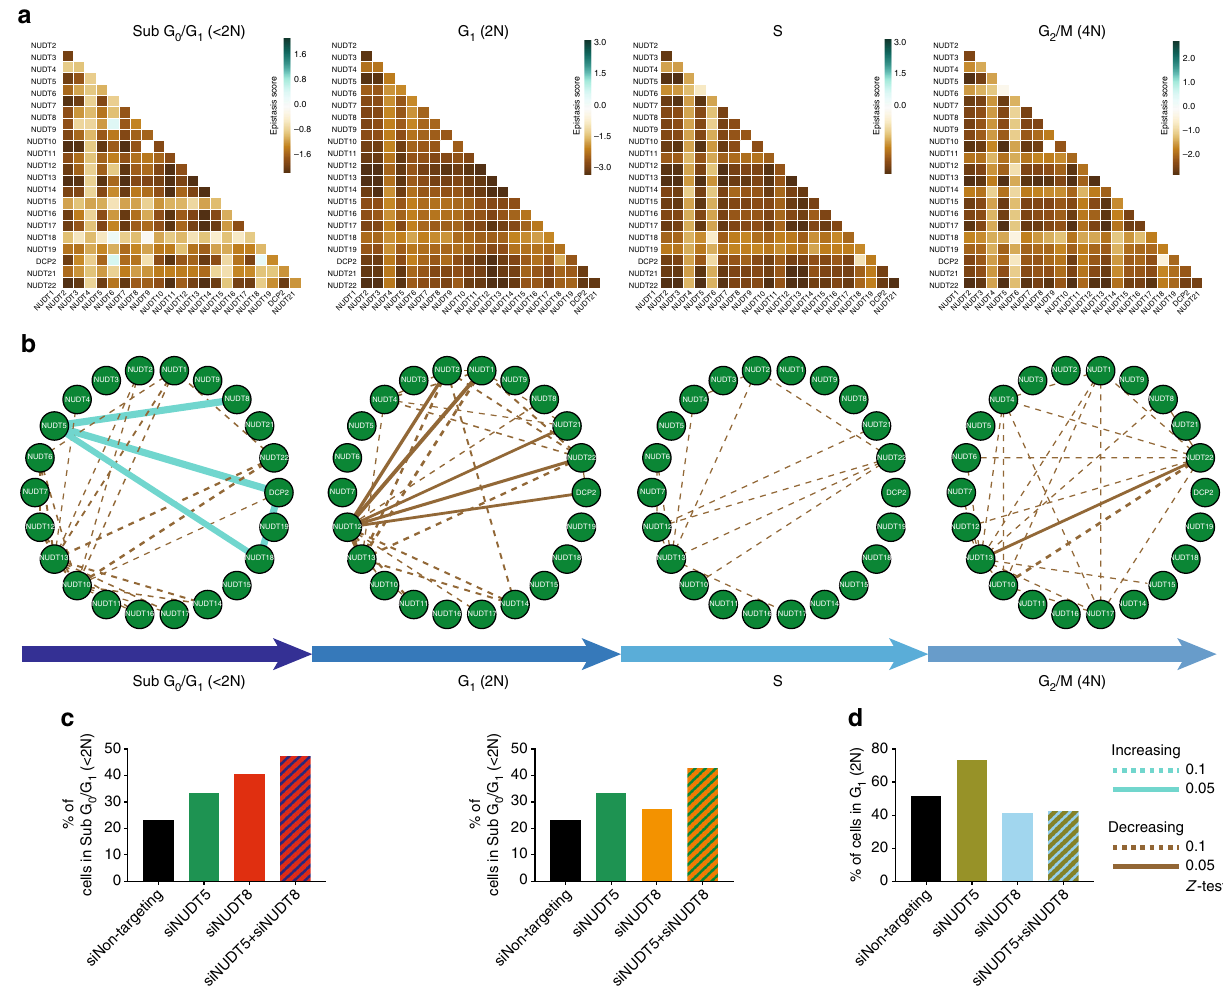
Fig. 6 Cell cycle genetic interactions between NUDIX genes. a Cell cycle-based interactions between NUDIX genes in the A549 cell line. The interaction maps visualize interactions determined based on the fraction of pairwise siRNA-depleted cells in each cell cycle phase. Shown is one interaction map per cell cycle phase. In each map, an interaction score was assigned to a pair of genes based on the difference between the observed cell fraction of the double knockdown and the expected cell fraction of the double knockdown. The expected cell fraction was determined using a multiplicative null model estimating the cell fraction of a double knockdown that would be expected if the genes were not interacting. The interaction maps include negative (or aggravating) interactions in brown, as well as positive (or alleviating) interactions in green. Alleviating interactions suggest that certain NUDIX product operate in concert or in series within the same pathway. b Statistically signi fi cant cell-cycle-based interactions between NUDIX genes in the A549 cell line are visualized using circular networks. The panel shows one network for each cell cycle phase. For each gene pair, the interaction was assessed by using a two- tailed Z -test ( α = 0.1). Edges in each network represent interactions whose values are signi fi cantly larger (indicating alleviating interaction) in cyan or signi fi cantly smaller (indicating aggravating interaction) in brown, than values in the 90% of interaction probability density. The interactions were selected independently and separately for each cell cycle phase in the A549 cell line. The width of network edges stands for statistical signi fi cance. c Bar charts indicating the increase in % of cells in SubG 0 /G 1 ( < 2 N) phase when NUDT5 and NUDT8, as well as NUDT5 and DCP2 are co-depleted. d Bar chart indicating the decrease in % of cells in G 1 (2 N) phase when NUDT1 and NUDT12 are co-depleted. The % of cells in each cell cycle phase were obtained by measuring the integrated intensity of the DNA counterstained with Hoechst, the signal was then processed using PopulationPro fi ler, as previously described